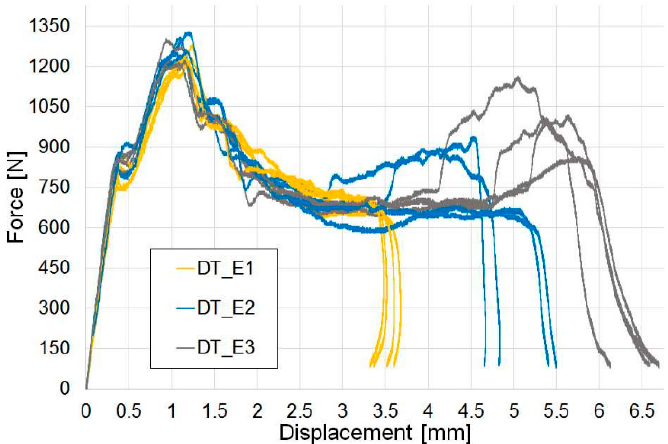
Figure 3. Drop tower impact tests: load-displacement curves for different energy levels: 2.2 J (DT_E1),